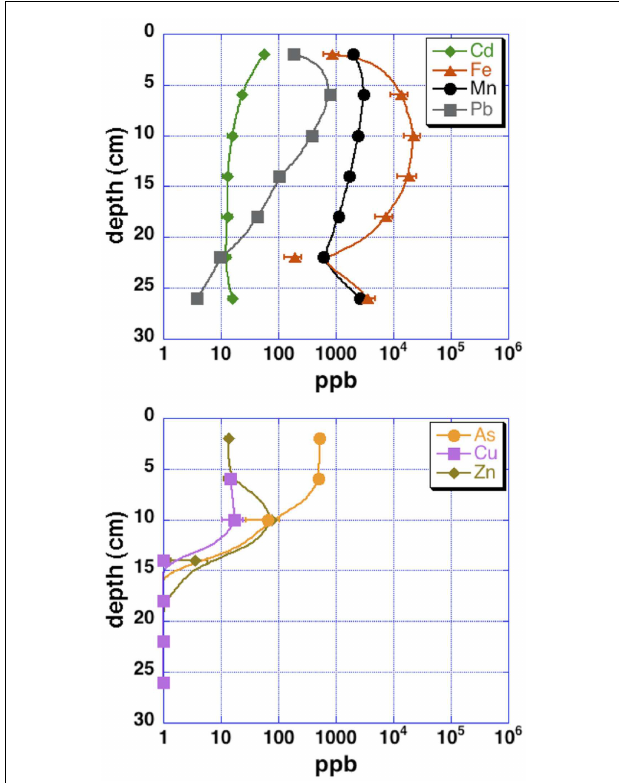
FIGURE 3 | X-ray diffraction pattern of cinders from Stege Marsh. J, S, P, L, H, and B stand for jarosite (elemental) sulfur, pyrite, lepidocrocite, hematite, and barite,